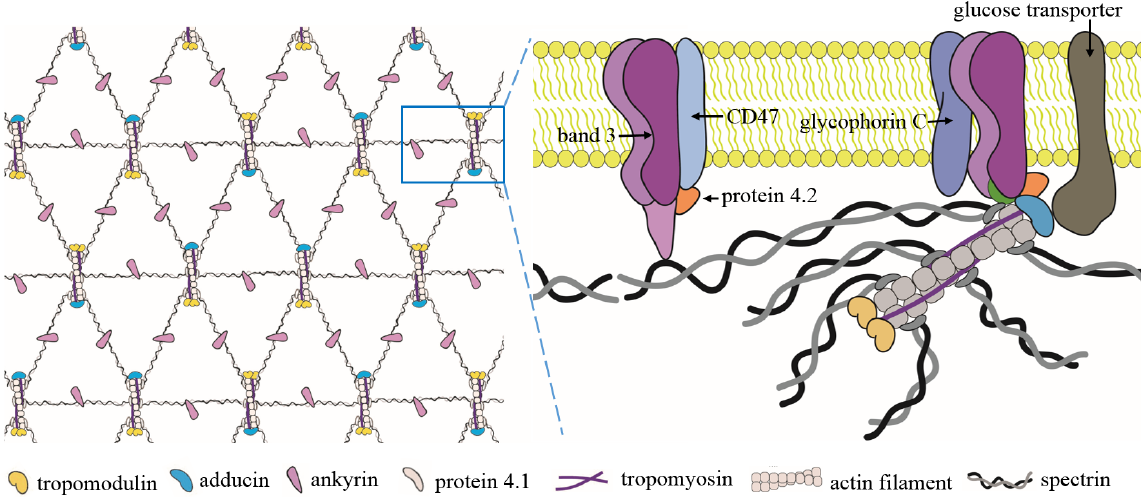
Fig. 1. Current model of the spectrin-actin-based structure of erythrocyte membrane-skeleton. A two-dimensional triangular meshwork composed of rod-like spectrin tetramers that connect at junctional complexes containing short actin ¯laments and associated